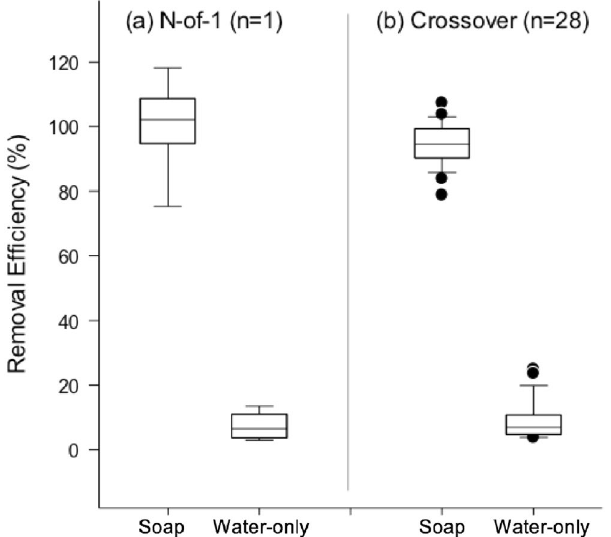
Figure 1. Box-Whisker plot showing the removal rate of dermal DEHP exposure of both hands in each study. ( a ) Average of the two N-of-1 trials on one female subject; ( b ) The crossover study on 28 study subjects.